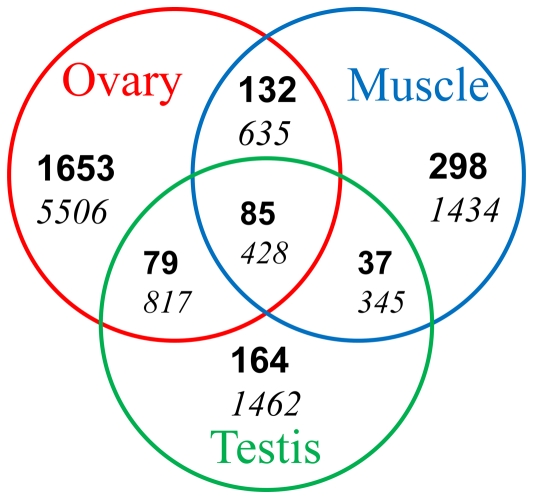
Comparative summary of M. rosenbergii transcriptomic sequences among three libraries.Putative sequence descriptions were counted using BLASTx results (E-value <1e–5) after excluding ribosomal proteins and redundant ones. Bold numbers indicate contigs and numbers in italics indicate singletons.